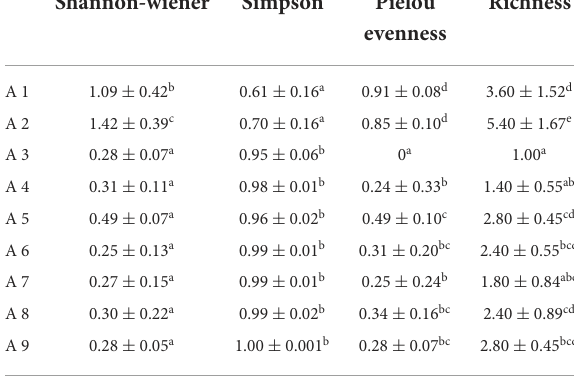
TABLE 1 Correlation analysis of plant functional group (PFG) importance values and biomass.